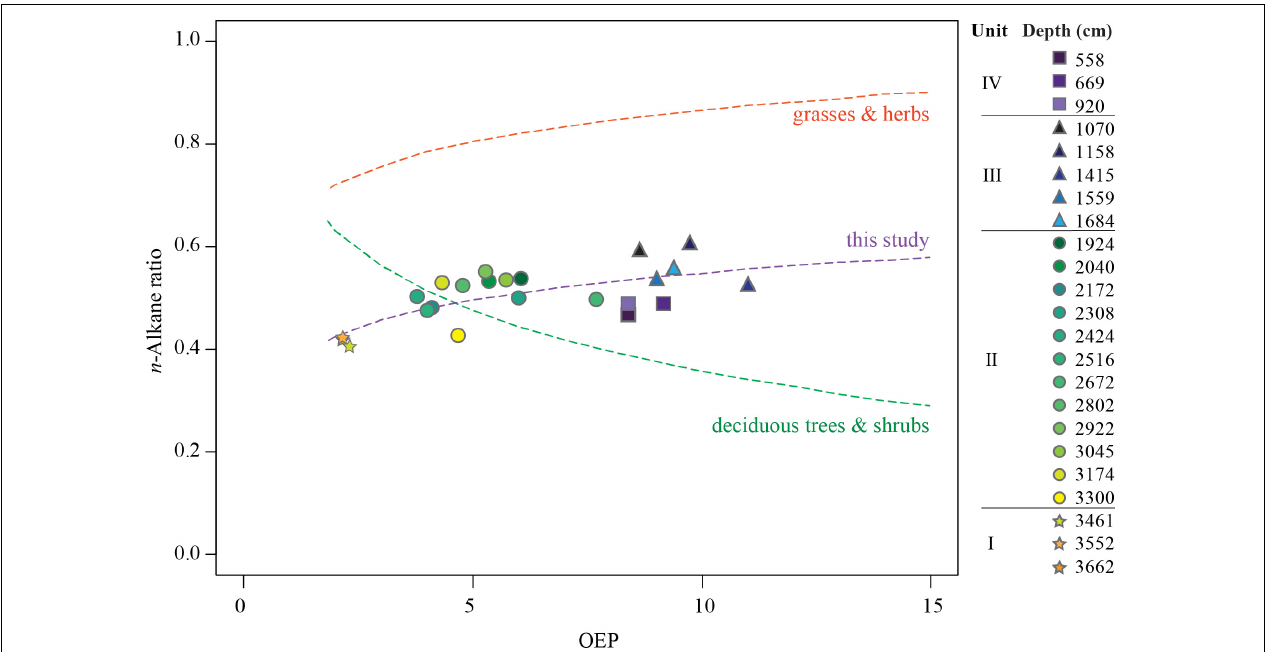
FIGURE 10 | n -Alkane endmember model of Goltsovoye Lake sediment core PG2412. Degradation line for grasses and herbs [dashed orange; y = 0.09*ln(OEP) + 0.66] and deciduous trees and shrubs [dashed green; y = 0.17*ln(OEP) + 0.75] after Zech et al. (2013) and Schäfer et al. (2016). Fitted line for this study [dashed purple; y = 0.08*ln(OEP) + 0.37]. n -Alkane ratio: ( n -C 31 + n -C 33 )/( n -C 27 + n -C 31 + n -C 33 ). Unit I: orange stars, Unit II: green circles, Unit III: blue triangles, Unit IV: purple